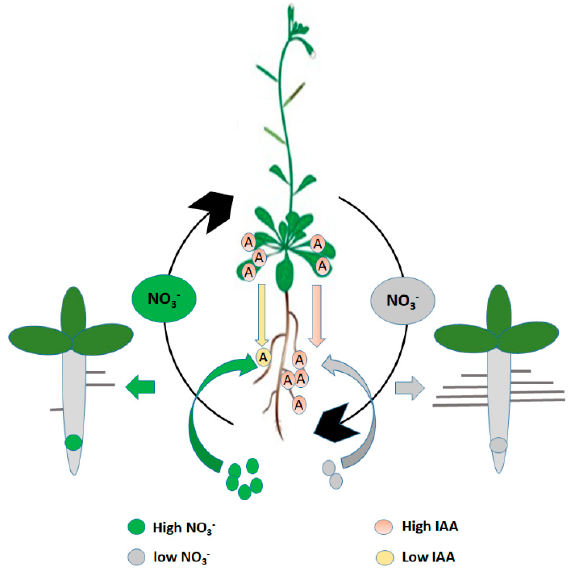
Figure3. TheschematicmodelrepresentsNO 3 − dependentshoot-rootauxintransportandaccumulation Figure 3. The schematic model represents NO 3 − dependent shoot-root auxin transport and inside the Arabidopsis root. “A” represents auxin accumulation inside the Arabidopsis root. “A” represents auxin (IAA).